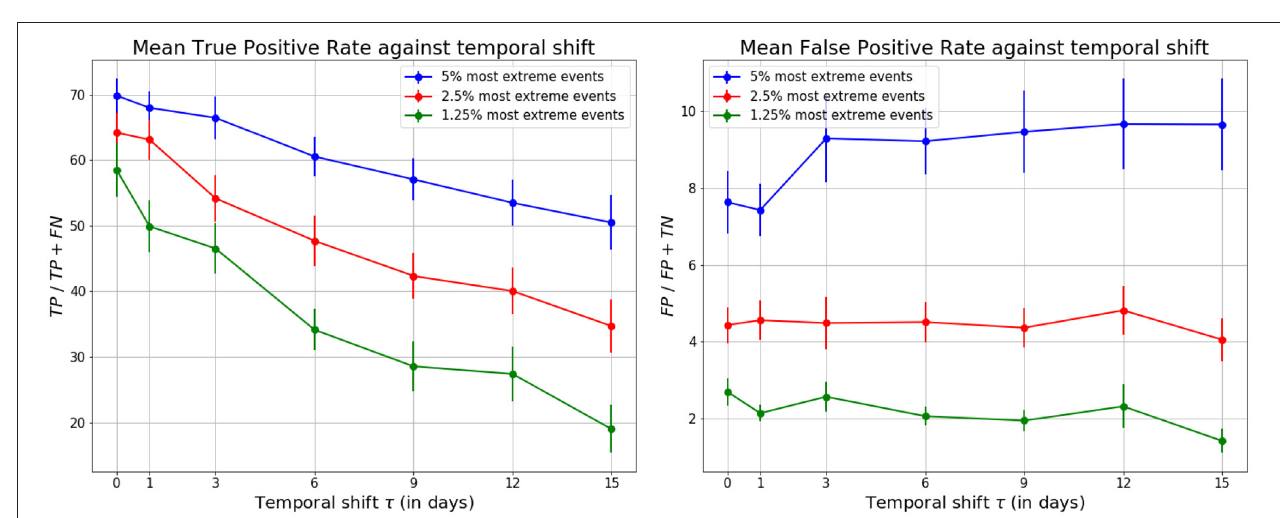
FIGURE 5 | Compared performance for heatwave occurrence prediction as a function of τ . Compared rates (in percentages) of True positive (left plot) and False positive (right plot) predictions, for each heatwave levels (5, 2.5, and 1.25 % ). Average across 40 independent learning as described in Figure 3 . Percentages of True Positives (resp. False Positives) are quantified with respect to the sizes of the positive (resp. negative)